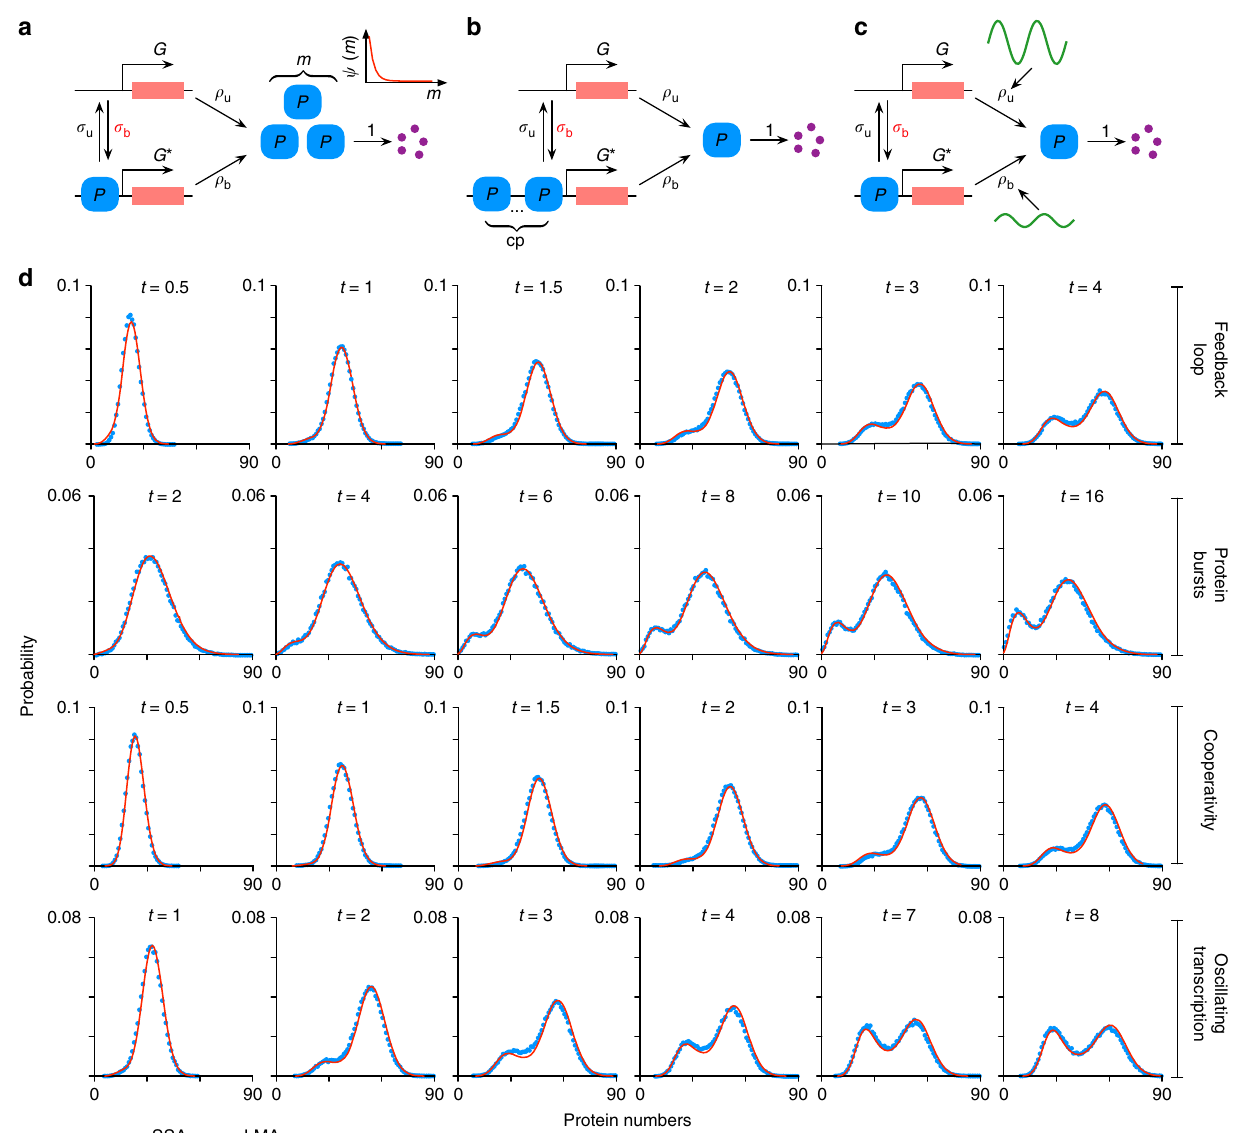
Fig. 2 LMA approximation for the time-dependent probability distribution of protein numbers for various nonlinear GRN. The feedback loop shown in Fig. 1a upper, a feedback loop with protein bursting ( a ), a feedback loop with cooperativity ( b ) and a feedback loop with oscillatory transcription ( c ). The inset of a shows the probability distribution ψ ( m ) of the protein burst size m : we consider a geometric distribution, the discrete analog of the exponential distribution which has been measured in experiments 15, 25 . The number of proteins binding to the promoter for the cooperative loop in b is given by cp. In d , we show snapshots of the protein number distribution at various times. The LMA approximation (red line) agrees with the results of stochastic simulations using the SSA (blue dots), and is able to capture the transition from unimodality at short times to bimodality at long times. The parameters are: for feedback loop ρ u = 60, ρ = 25, σ = 0.004, σ = 0.25; for protein bursts ρ = 20, ρ = 5, σ = 10 − 3 , σ = 0.1 and the mean burst size b = 2; for cooperativity ρ b b u u b b u 25, σ b = 5 × 10 − 5 , σ u = 0.25 and cooperativity order cp = 2; for oscillating transcription, the parameters are ρ u = 60, ρ b = 25, Am = 0.3, k = 1.33, σ b = 0.004, σ u = 0.25. The SSA result in each snapshot is obtained by averaging over 80,000 realizations and the sampling error is <2% for each point in the SSA probability distribution. In all cases, the initial conditions are zero protein in promoter state